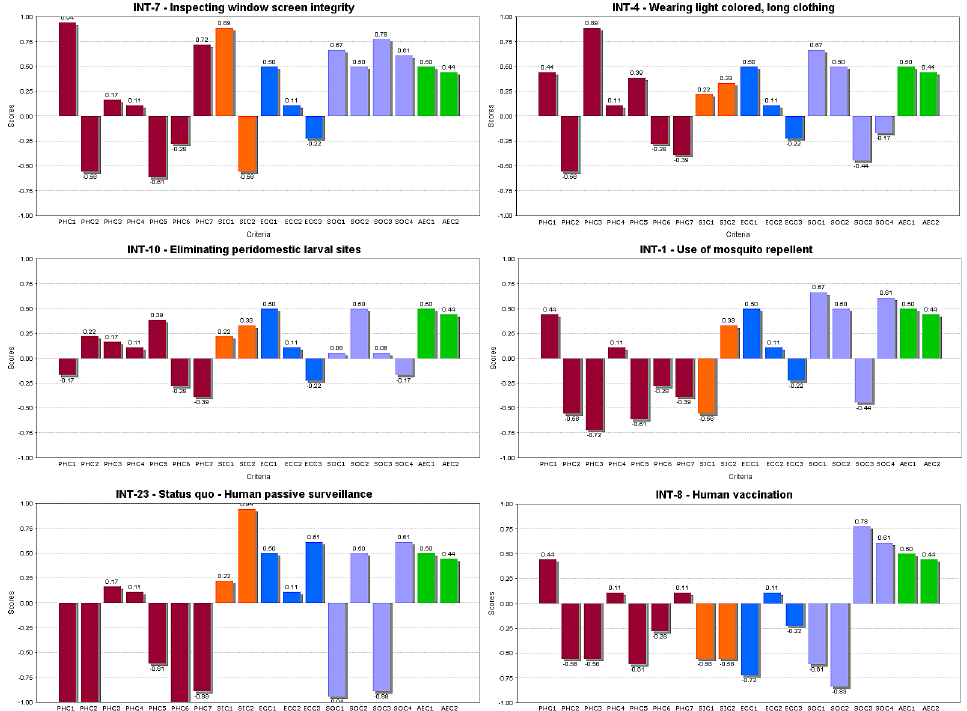
Fig 3. Intervention profiles for six individual-level protection interventions. Each bar represents one of the criteria included in the model. Values along the vertical axis indicate the scores received for the intervention on a particular criterion. Values above zero indicate good performance of the intervention for that criterion based on evaluation scores and conversely, values below zero indicate “ poor ” relative performance. Criteria bar color codes: red: Public Health criteria; orange: Social Impact criteria; blue: Economic criteria; purple: Strategic and Operational criteria; green: Animal and Environmental Health criteria. (Please refer to supplementary material for all other intervention